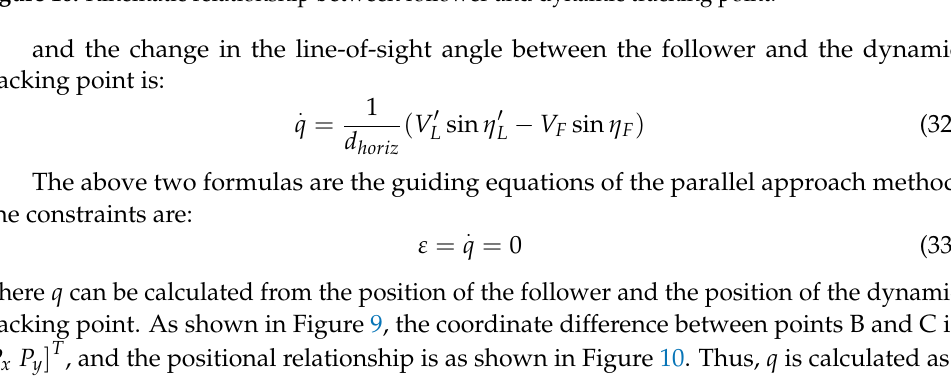
Figure 10. Kinematic relationship between follower and dynamic tracking point.